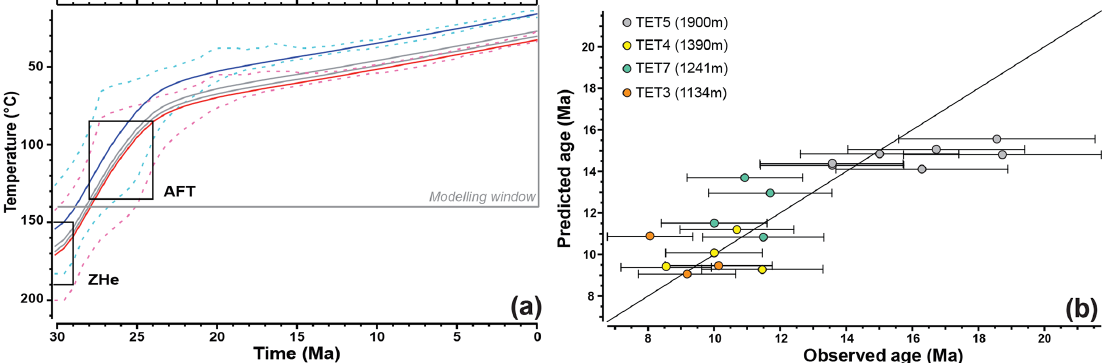
Figure 2. (a) Regional thermal history of the Carança–Canigou range (Têt fault footwall). Thermal modelling was computed with QTQt software (Gallagher, 2012) and Gautheron et al. (2009) diffusion parameters using AHe data from Milesi et al. (2019) and AFT and ZHe data from Maurel et al. (2008). Blue and red T-t paths correspond to the computed thermal history of the most and least elevated samples, respectively. Dashed lines: 95 % confidence interval of T-t paths. (b) Predicted age vs. observed age graph for each apatite grain. The 1 : 1 diagonal line corresponds to an ideal fit of these